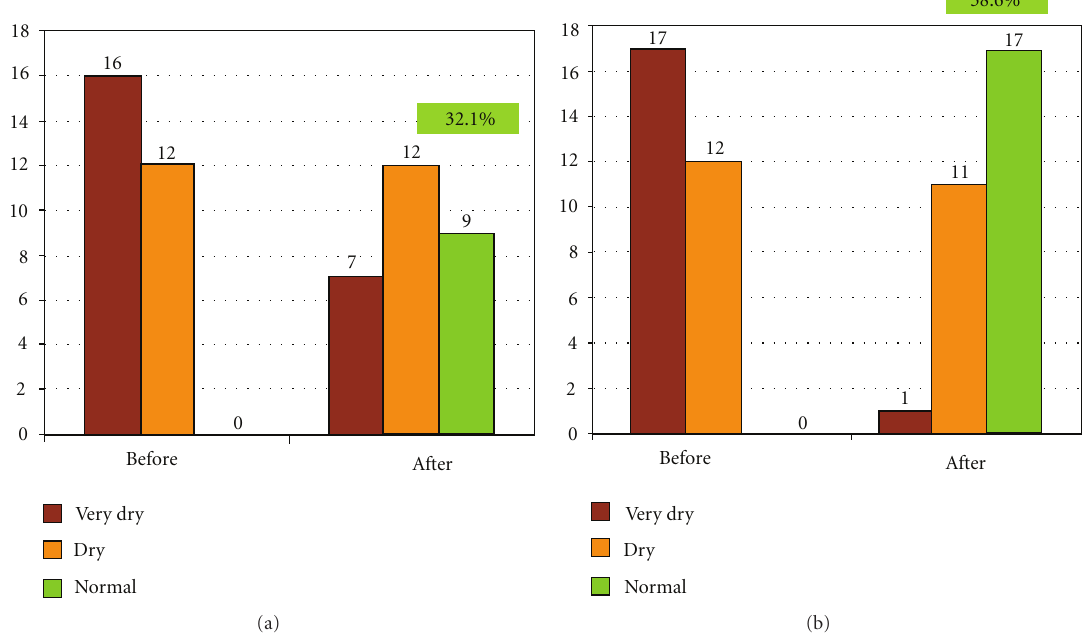
Figure 1: 32.1% of vehicle-control subjects (a) and 58.6% of MPS subjects (b) demonstrated improvement to normal skin hydration after 4 weeks of application ( P < 0 . 01).